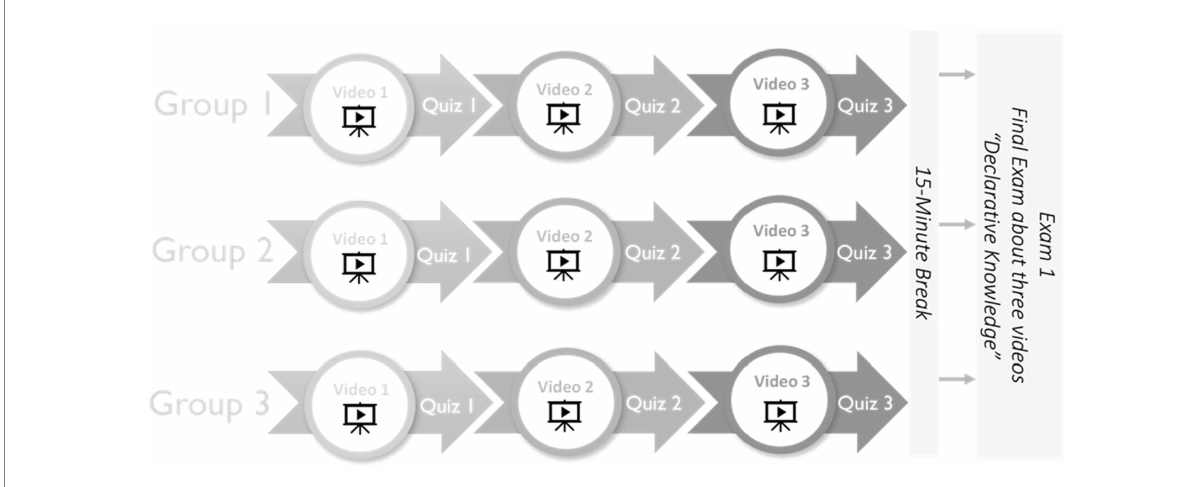
FIGURE 3 Procedure for experimental phase 1: Declarative knowledge.